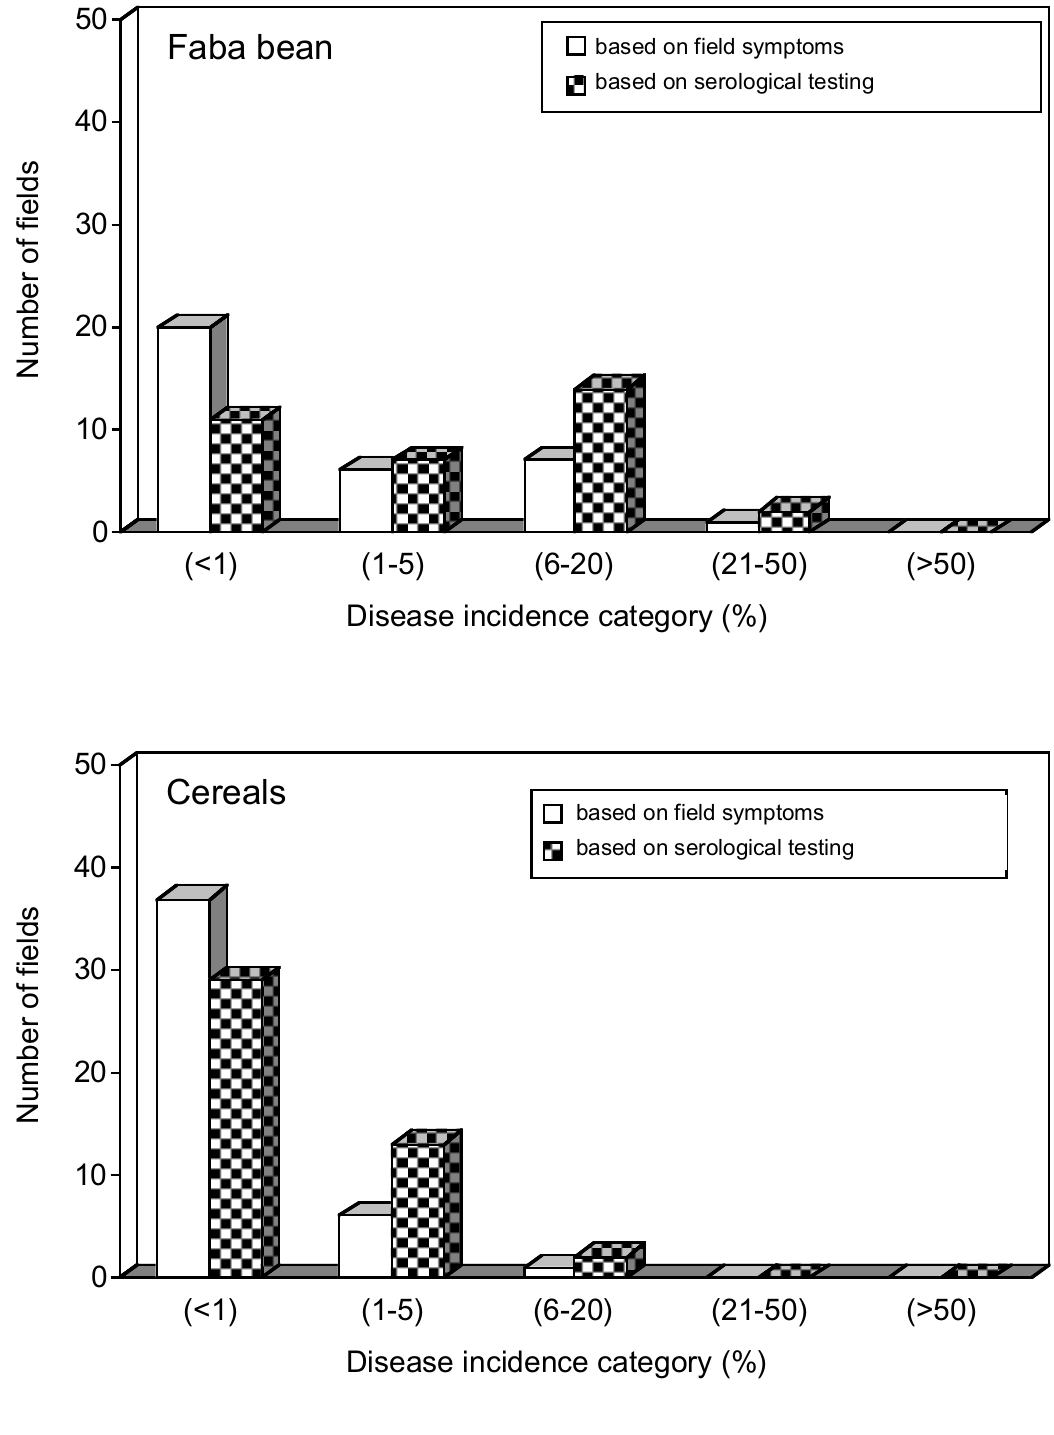
Fig. 2. Virus infection incidence in faba bean and cereal crops based on symptoms observed in the field and labora- tory testing of randomly collected samples. Survey conducted in Tunisia, April,